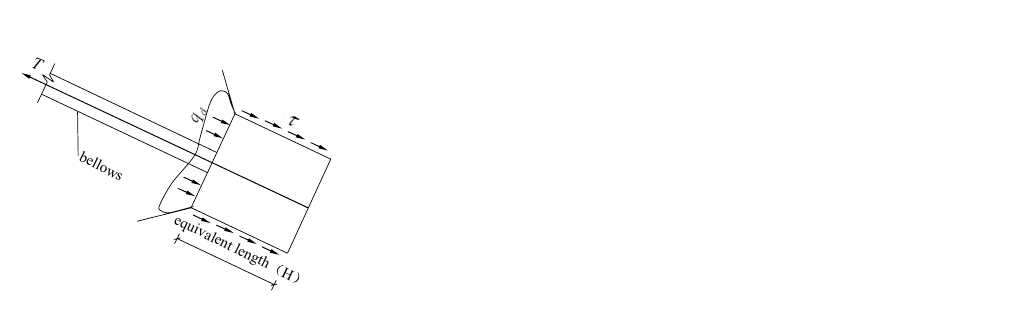
Figure 4. Force diagram of the anchor-pulling system in the phase of transition (joint of plastic zone).